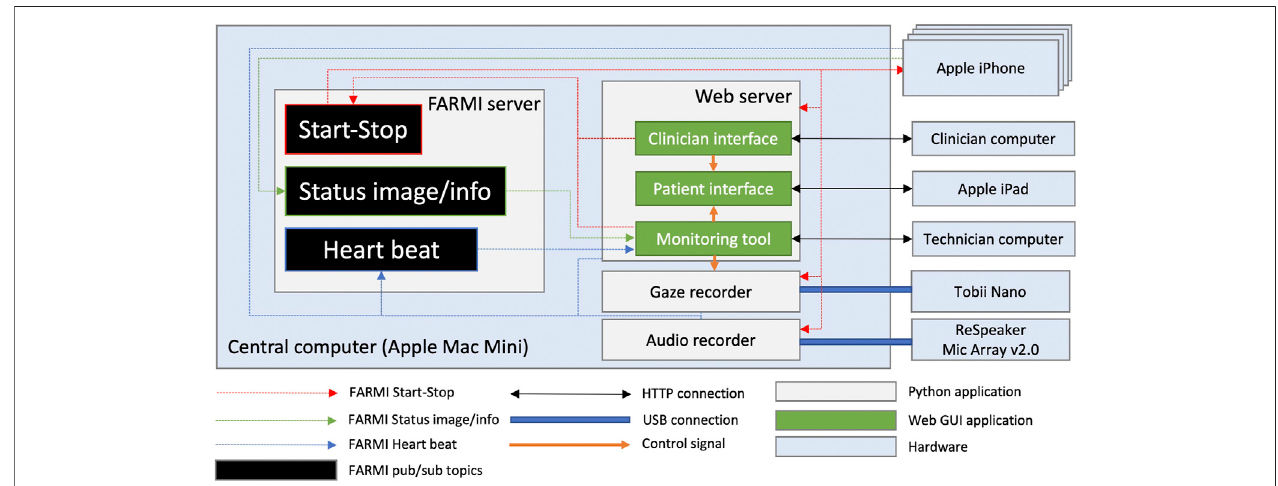
FIGURE 5 | Interface of the monitoring tool used by the technician. The images from the cameras have been cropped out for privacy reasons.